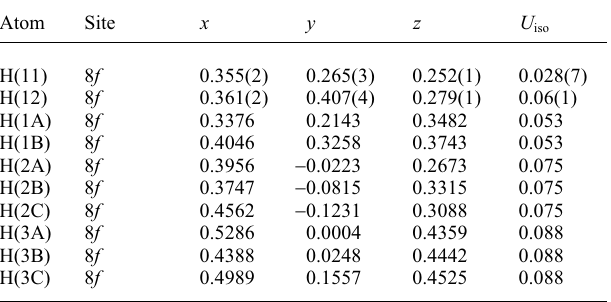
Table 2. Atomic coordinates and displacement parameters (in Å 2 )